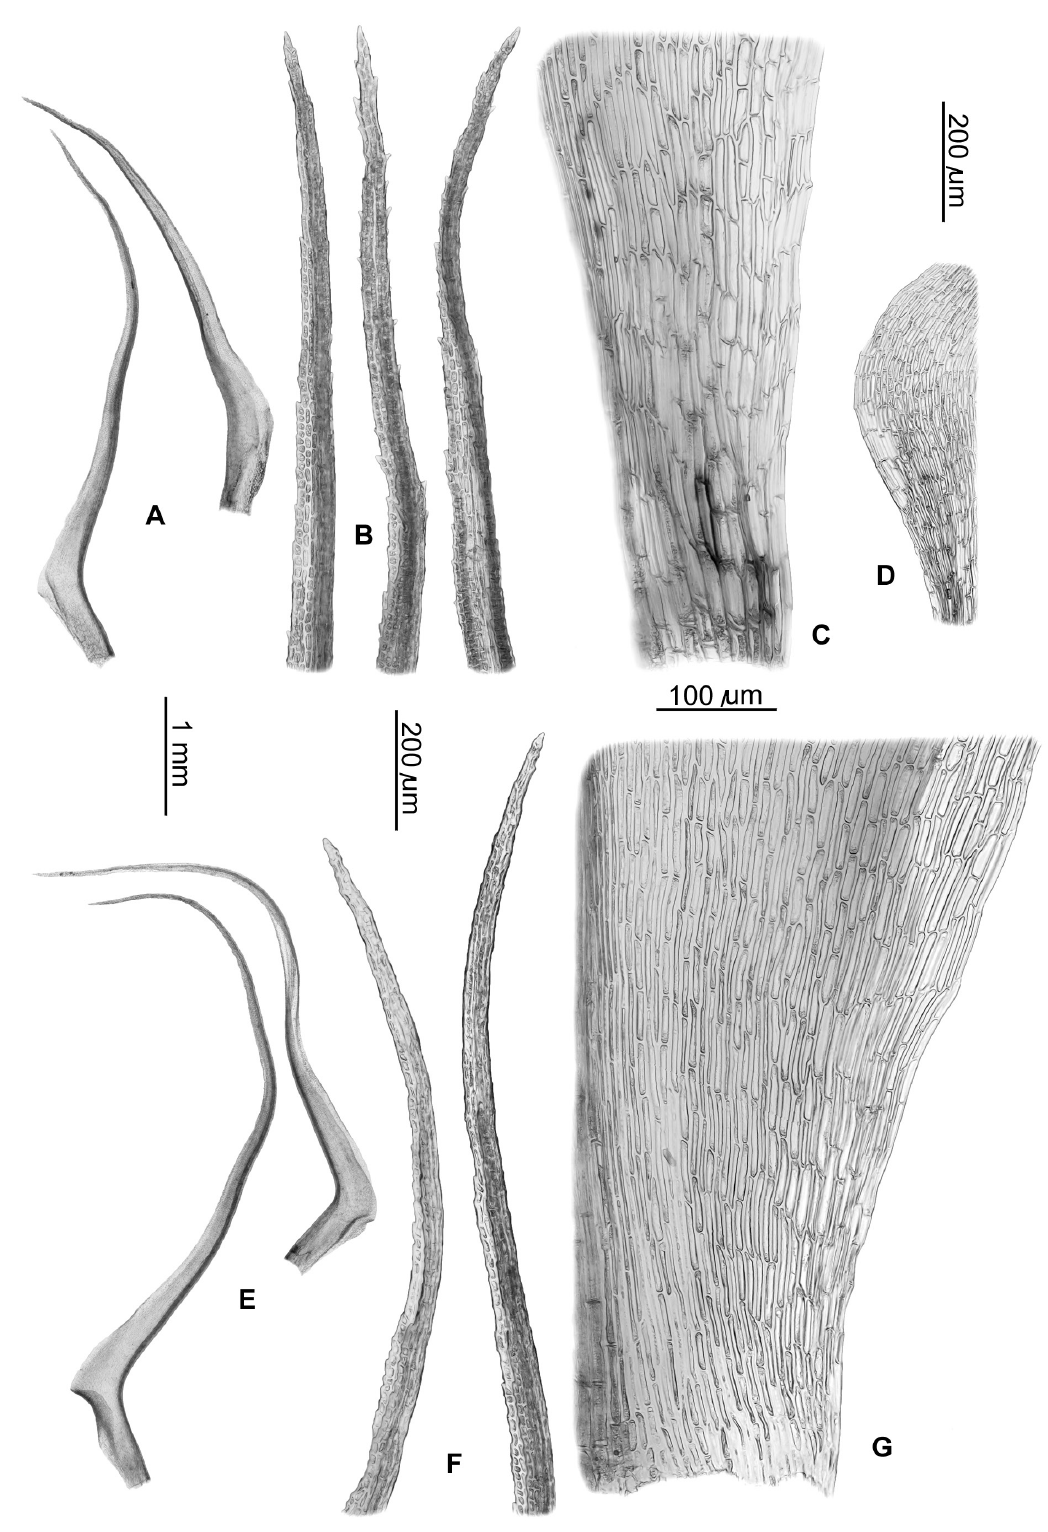
Fig. 6. A–D . Oncophorus elongatus A (specimen P251; cf., Table 1). E–G . O. elongatus B (specimen P221, cf. Table 1). A, E . Stem leaves. B, F . Upper leaf acumen. C, G . Marginal and alar portions of sheathing leaf base (margin to the right). D . Portion of leaf at widest point, showing the flat